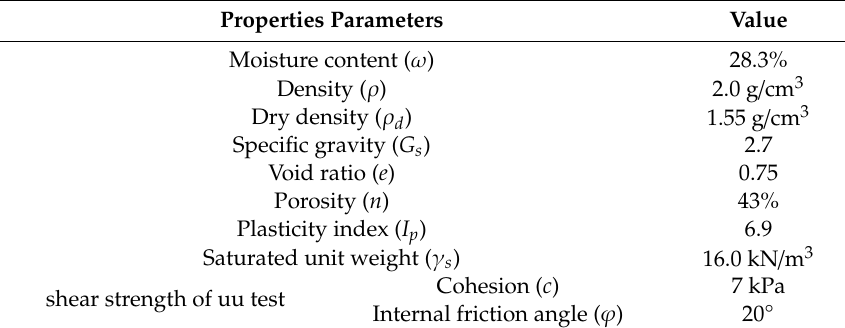
Table 2. Summary of the parameters of the test